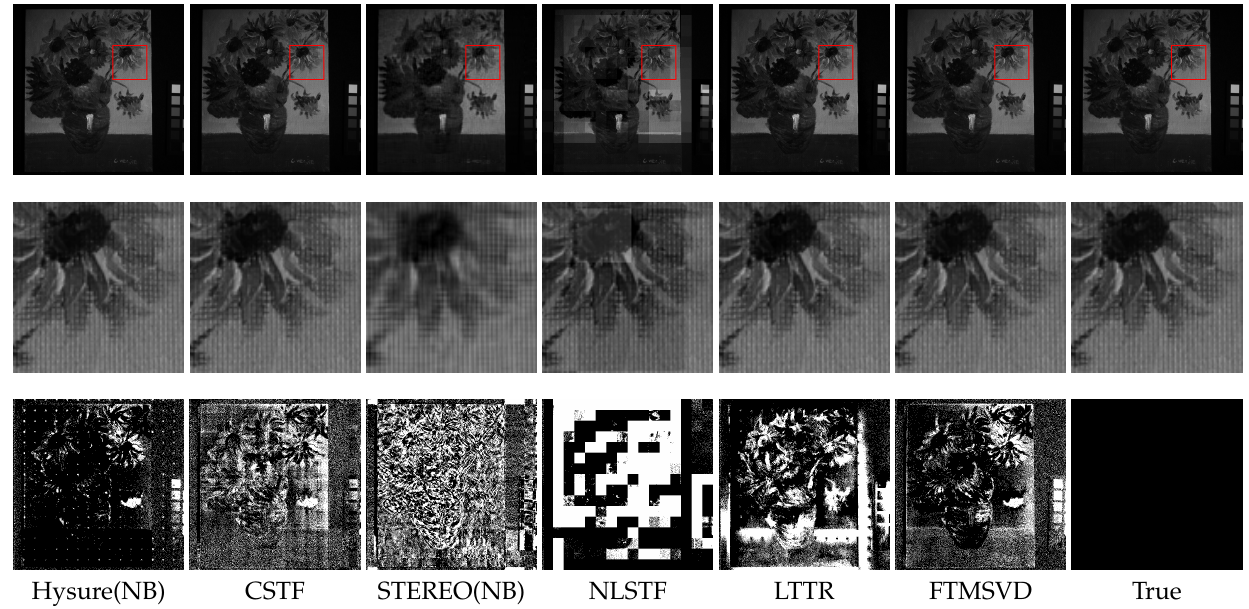
Figure 4. The first row shows the fused images by the competing methods for oil_painting_ms (CAVE data set) at band 16. The second row shows the magnified version of the marked area. The third row shows the error images of the test methods for oil_painting_ms at band